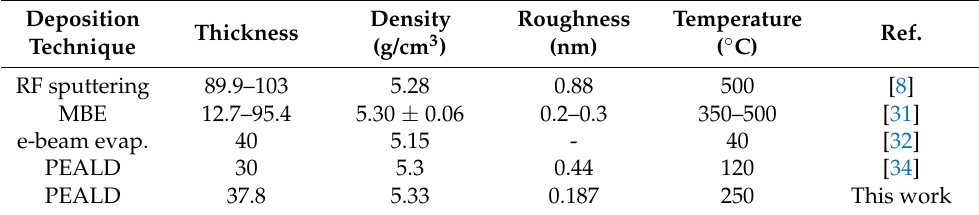
Table 2. Density and roughness of Ga 2 O 3 films grown by diverse deposition techniques. Reported data of this work are included for